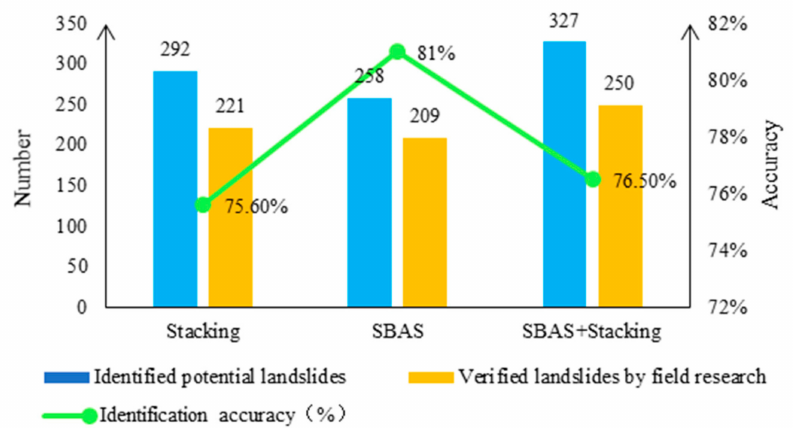
Figure 11. Statistics of landslide identification results by SBAS technology and Stacking technology in the study